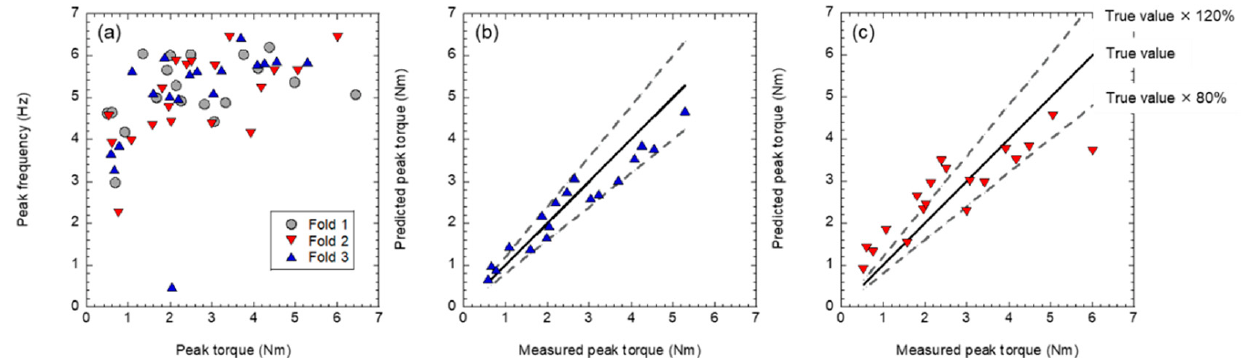
Figure 10. Demonstration of machine learning-based diagnosis of polyaxial pedicle screw evaluated by three-fold cross- validation: ( a ) fold term, ( b ) prediction result of Fold 3 with Fold 1 and Fold 2 training data, and ( c ) prediction result of Fold 2 with Fold 1 and Fold 3 training data.